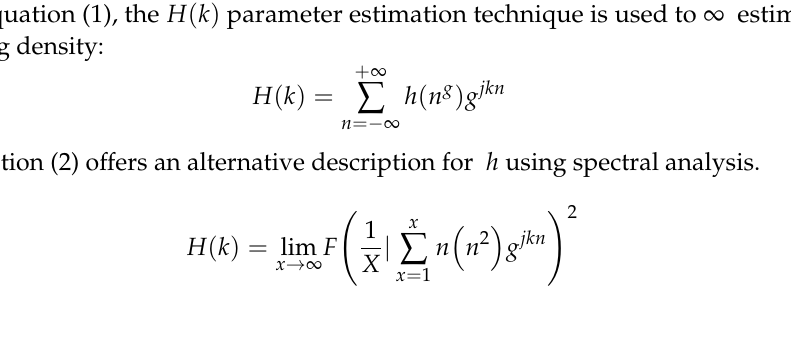
Figure 1. Proposed model for an online practical agriculture course. Proposed Algorithm